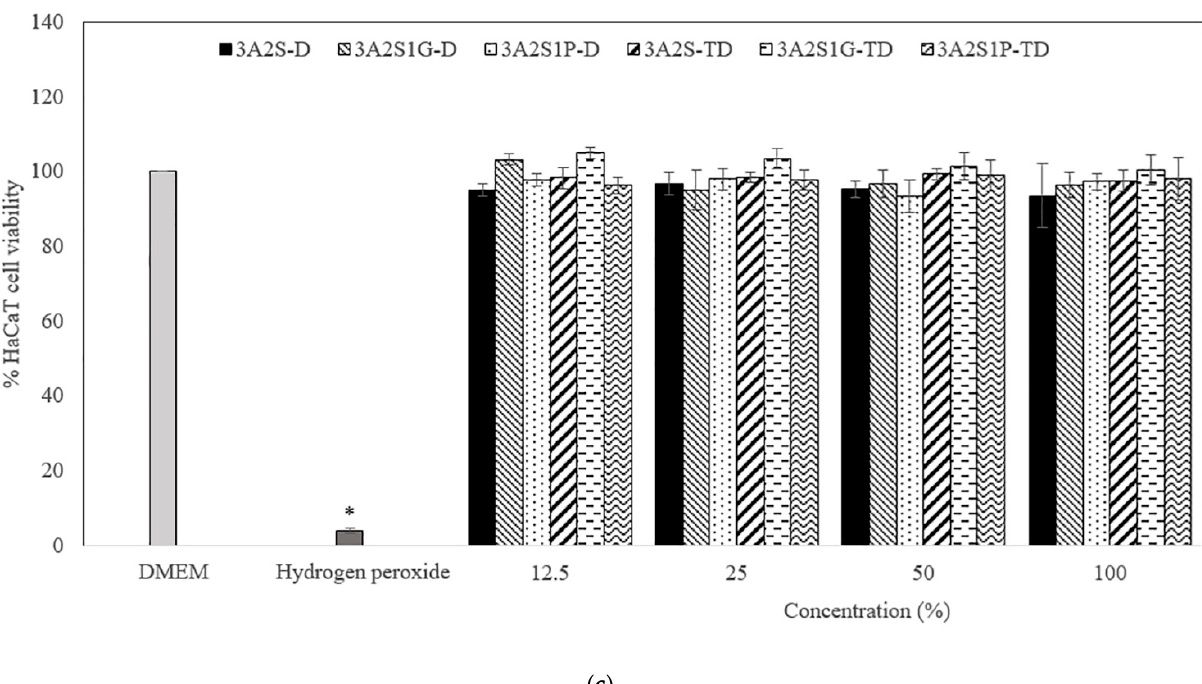
Figure 7. The percentage viability of HaCaT cells after treatment with different concentrations (12.5%, 25%, 50%, and 100%) of the released scaffolds (3A2S, 3A2S1G, 3A2S1P) that were prepared by the freeze-drying method (D) and by freeze-thawing together with the freeze-drying method (TD) at ( a ) 24 h, ( b ) 48 h, and ( c ) 72 h (* significant difference compared to other samples; p < 0.001).